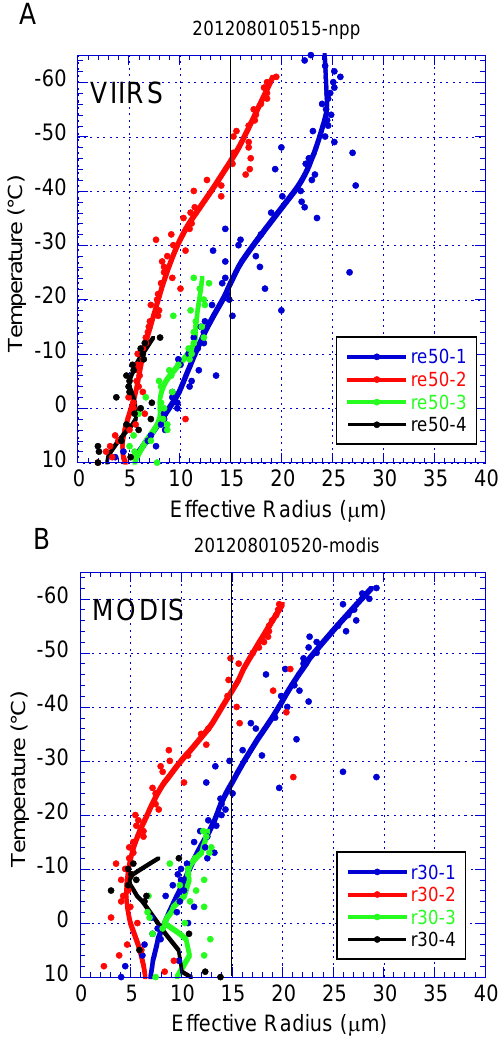
Fig. 24. Comparison between the T – r e relations of continental deep convection and pyro-Cb, as seen by VIIRS and MODIS, for the case shown in Fig. 23. The red line is from a pyro-Cb; the black line is from Cu clouds that develop in smoke from adjacent fire; the blue and green lines are from Cb and Cu clouds that are not affected by the smoke. The lower parts of the MODIS retrieved r e increased anomalously in most of the clouds, probably due to contamination from the smoke and partial pixel filling. This was not a problem in